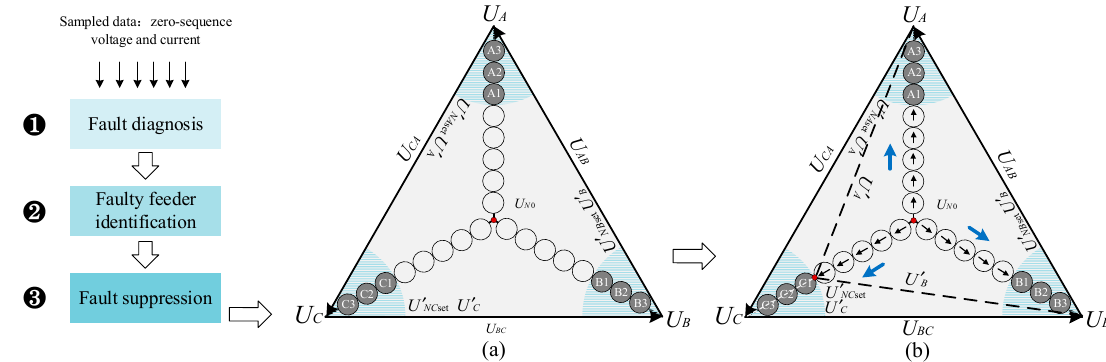
Figure 3. Schematic diagram of neutral-point voltage compensation strategy. ( a ) Before the compensation; ( b ) after the compensation.